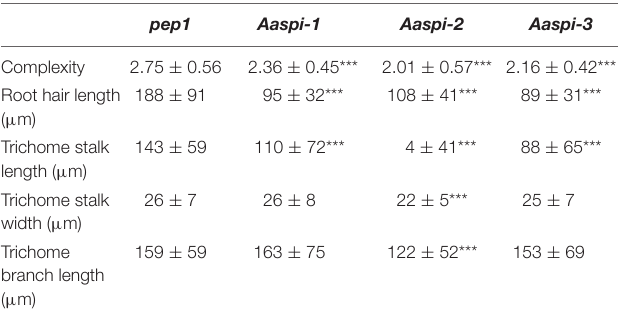
TABLE 1 | Cell complexity, root hair length and trichome measurements in pep1 and Aaspi mutants.